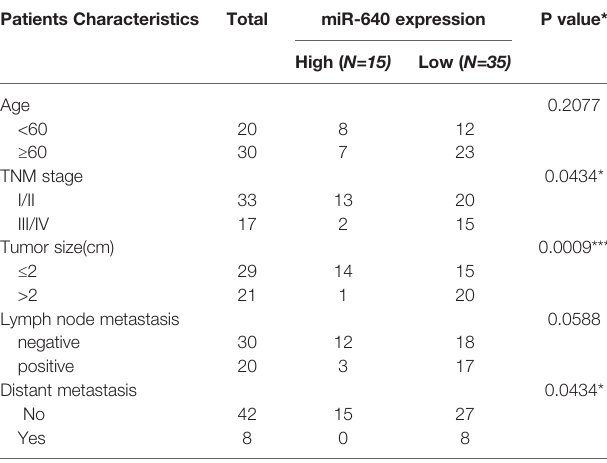
TABLE 1 | The relationship between the expression of miR-640 and various clinicopathological variables. Patients